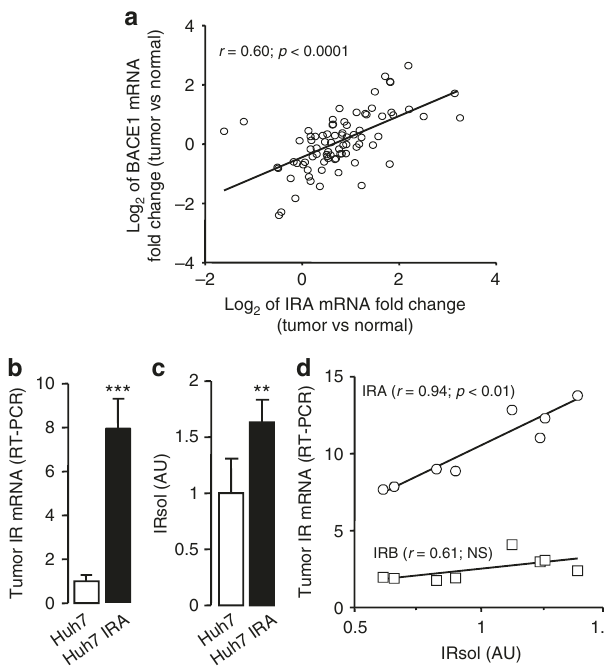
Fig. 10 IR cleavage in tumors. a Pearson ’ s correlation of the changes in IRA mRNA levels in hepatocellular carcinoma vs. normal tissue with those of BACE1 (values are expressed in Log 2 ). Pearson ’ s correlation coef fi cient ( r ) and p -value are reported. b IR mRNA levels were measured by RT-PCR in tumors from native Huh7 cells and from Huh7 cells overexpressing IRA (Huh7 IRA). c IRsol was measured in the plasma of mice-bearing tumors from native Huh7 cells and from Huh7 cells overexpressing IRA (Huh7 IRA). Data are means± s.d. ** p < 0.01; *** p < 0.001. d Correlation of IRA (circles) and IRB (squares) mRNA levels in tumors from native Huh7 cells with IRsol plasma levels (IRsol values are expressed as fold over the mean). Pearson ’ s correlation coef fi cient ( r ) and p -value are reported (NS,